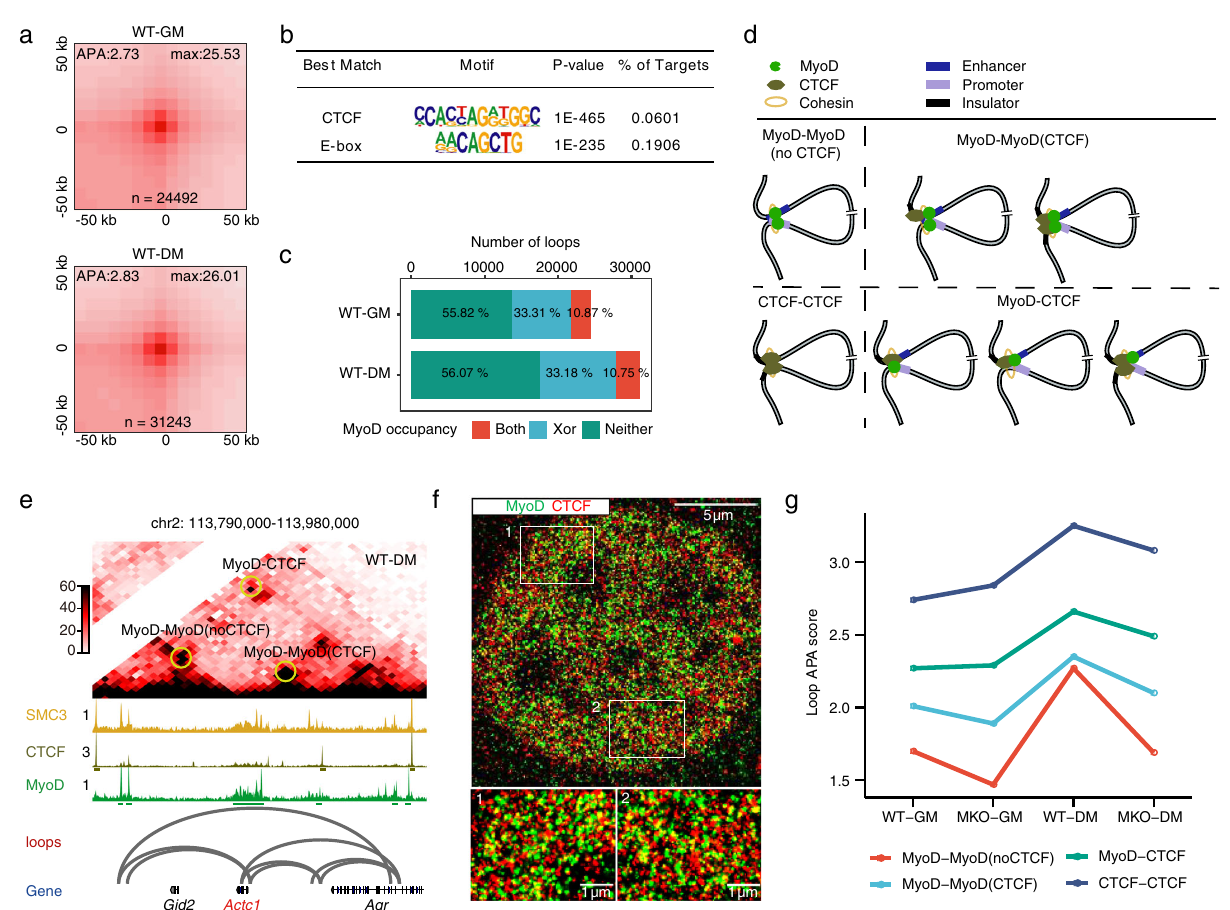
Fig. 2 MyoD is an anchor protein for chromatin loop formation in muscle cells. a Aggregate Peak Analysis (APA) plots showing the aggregated Hi-C contacts around chromatin loops identi fi ed in WT-GM and WT-DM cells. n represents the total number of chromatin loops called by HiCCUPS (see Methods). The APA score at the upper left corner of each aggregation plot was calculated as the ratio of Hi-C contacts at the central pixel to the mean Hi-C contacts of the lower-left pixels. The Hi-C contacts at the central pixel are shown at upper right corner of each aggregation plot. b Enriched motifs in accessible regions at the anchors of the chromatin loops identi fi ed in panel a . p -values of motif enrichment were determined using cumulative binomial distributions, as applied by Homer. c Percentage of chromatin loops with anchors bound by MyoD in WT-GM and WT-DM cells. MyoD is indicated as being bound at both anchors (Both, red), one of the two anchors (Xor, blue), or neither of the two anchors (Neither, green). Pseudo-peaks of MyoD binding derived from combined ChIP-seq data of public databases and our study were used for this analysis (Methods). d Classi fi cation of the four types of chromatin loops identi fi ed in the study. MyoD-MyoD(noCTCF) loops had both anchors bound only by MyoD. MyoD-MyoD(CTCF) loops had both anchors bound by MyoD and either anchor concomitantly bound by CTCF. MyoD-CTCF loops had only one anchor bound by MyoD and either anchor bound with CTCF. CTCF-CTCF loops had both anchors bound only by CTCF. e Representative examples of the MyoD-bound chromatin loops. ChIP-seq data of SMC3 in C2C12 cells were obtained from the public database (GSE113248). f dSTORM image showing colocalization of MyoD (green) and CTCF (red) from immuno fl uorescent staining of C2C12 cells grown in DM for 24h and stained with antibodies against MyoD and CTCF. The image is representative of three independent experiments. g APA score dynamics for the four types of chromatin loops among WT and MKO cells grown in GM and